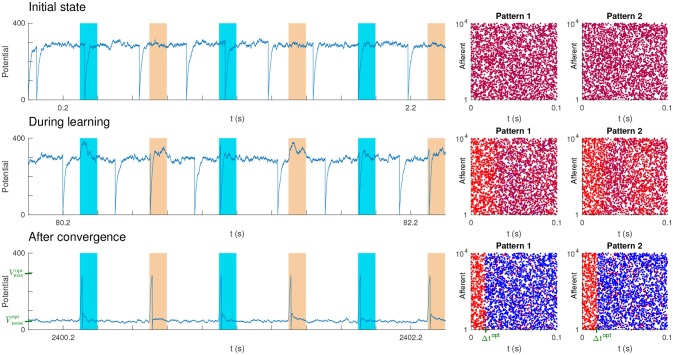
Unsupervised STDP-based pattern learning. The neuron becomes selective to P = 2 patterns. (Top) Initial state. On the left, we plotted the neuron's potential as a function of time. Colored rectangles indicate pattern presentations. Next, we plotted the two spike patterns, coloring the spikes as a function of the corresponding synaptic weights: blue for low weight (0), purple for intermediate weight, and red for high weight (1). Initial weights were uniform (here at 0.7, so the initial color is close to red). (Middle) During learning. Selectivity progressively emerges. (Bottom) After convergence. STDP has concentrated the weights on the afferents which fire at least once in at least one of the pattern subsections, located at the beginning of each pattern, and whose duration roughly matches the optimal Δt (shown in green). This results in one postsynaptic spike each time either one of the two pattern is presented. Elsewhere both V¯noise and σnoise are low, so the SNR is high. In addition V¯noise roughly matches the theoretical value V¯noiseopt (shown in green), corresponding to the optimal SNR. We also show in green Vmaxopt, the theoretical optimal value for Vmax. However, the potential never reaches it, because the adaptive threshold is reached before.